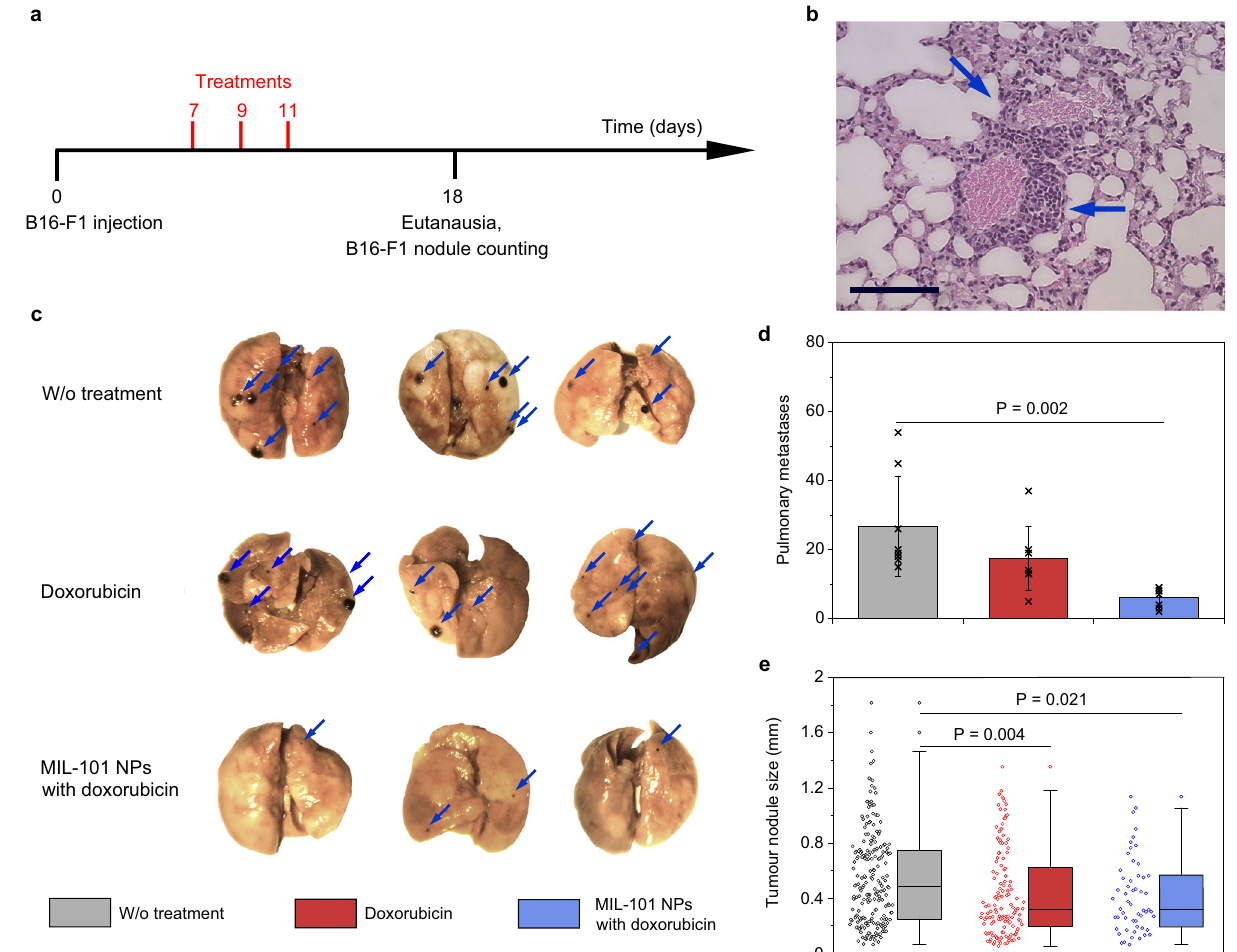
Fig. 7 | Doxorubicin-loaded MIL-101 NPs effectively treat melanoma in late- stage pulmonary metastasis model. a Treatment schedule. b Representative histological images, showing extravasation of B16-F1 melanoma cells from blood vessel to surrounding tissue. Scale bar=100 µ m. n =3 mice. c Representative ima- ges of the lungs, collected on Day 18 post cancer cell administration. Mice were treated with PBS (top line), doxorubicin (middle line), or doxorubicin-loaded MIL- 101 NPs (bottom line). Blue arrows point to melanoma metastases. n =3 mice. d Quanti fi cation of the surface nodule metastases in the harvested lungs after the treatment with PBS (grey), doxorubicin (red) or doxorubicin-loaded MIL-101 NPs